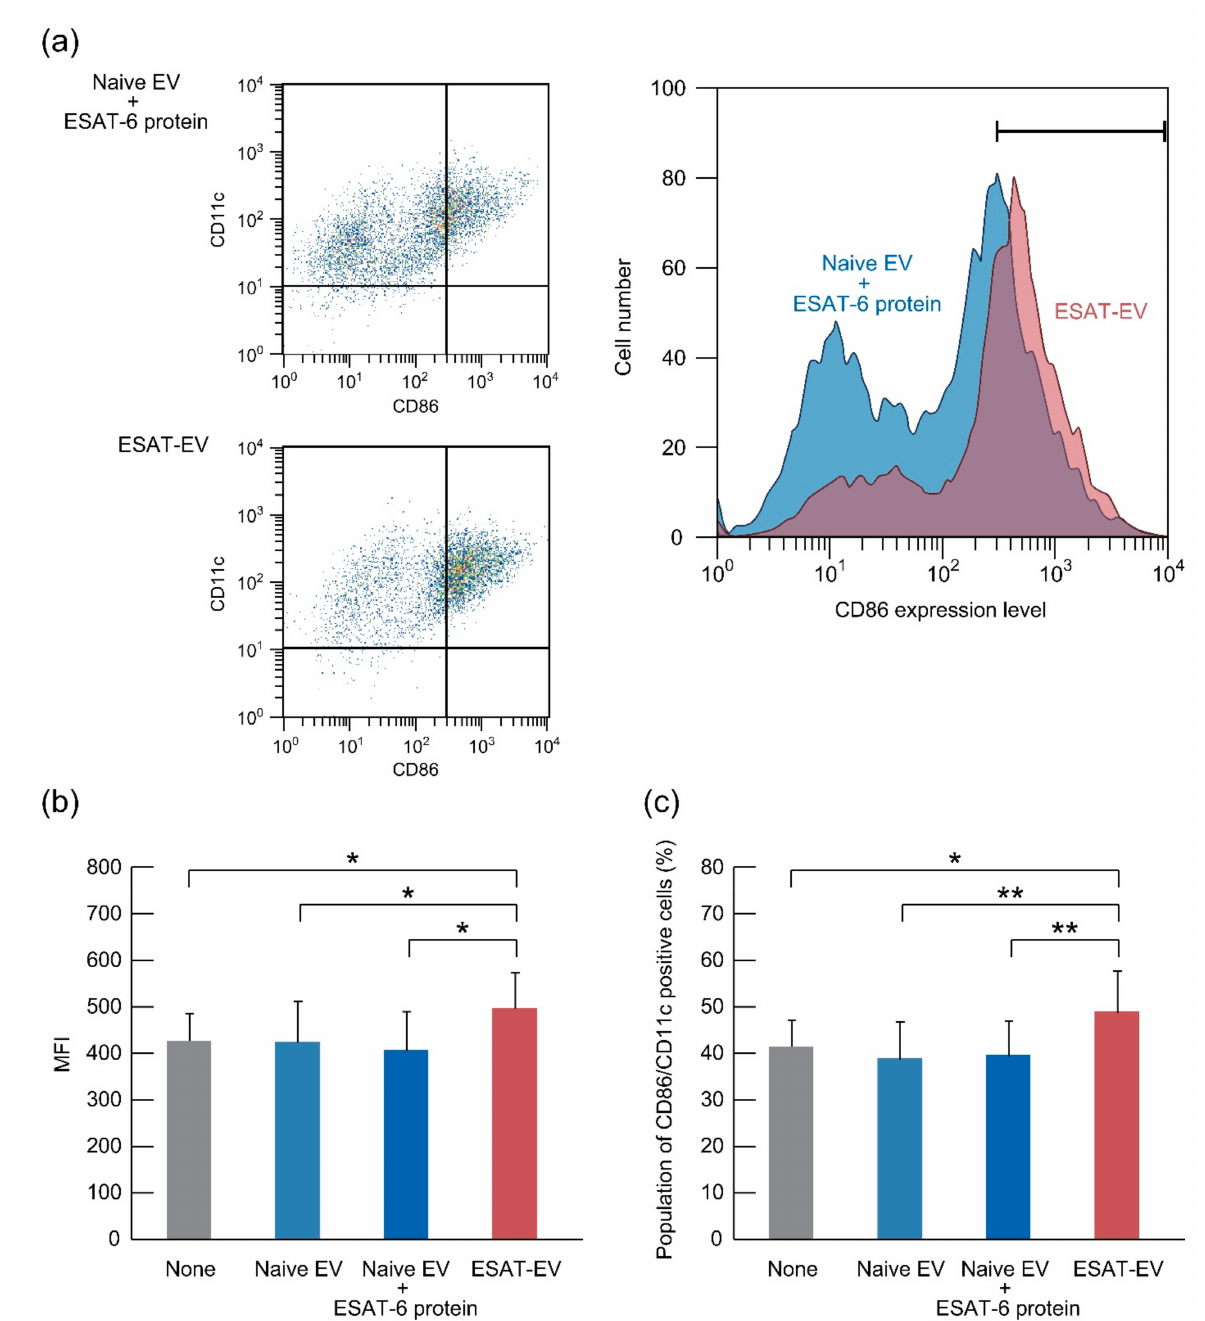
Figure 5. Expression of CD86 by cultured dendritic cells (DCs) treated with ESAT-EV, Naive EV, or a mixture of Naive EV and ESAT-6 protein. DCs were differentiated from the bone marrow cells of C57BL/6 mice, and incubated with ESAT-EV, Naive EV, or a mixture of Naive EV and ESAT-6 protein. After one day of incubation, CD86 protein expressed in the cells was analyzed with a flow cytometer. ( a ) Left, representative dot plots, and right, overlaid histograms of the fluorescence intensity of CD86 in CD11c positive cells treated by ESAT-EV (red) or Naive EV + ESAT-6 protein (blue); ( b ) Mean fluorescence intensity of CD86 in CD11c positive cells ( n = 3, mean ± SD, * p < 0.05); ( c ) Population of the cells with a fluorescence intensity of PE-Cy7-CD86 over 300 counts ( n = 3, mean ± SD, * p < 0.05 and ** p <